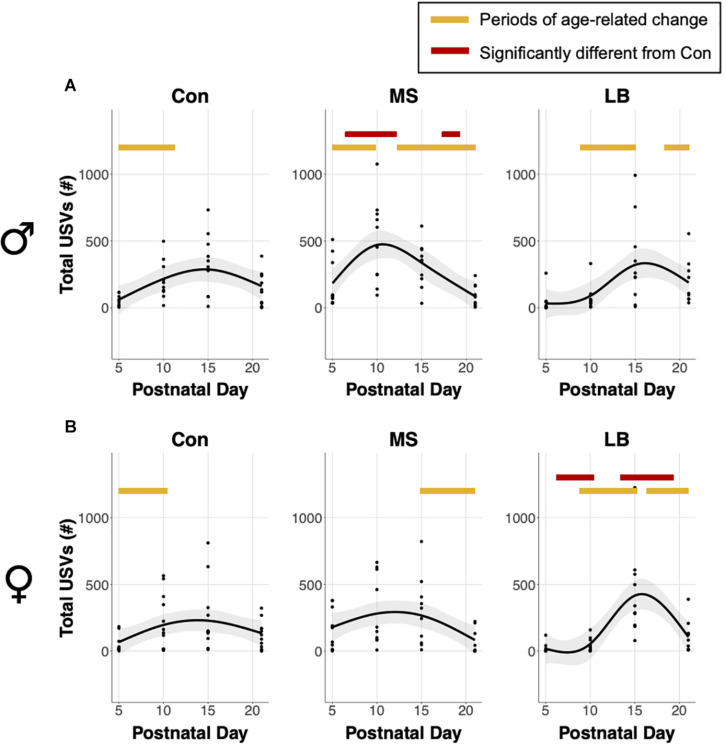
Effects of age and maternal separation (MS) or limited bedding (LB) on total ultrasonic vocalizations (USVs) emitted in (A) males and (B) females. Shaded areas represent 95% confidence intervals. Orange bars indicate periods of significant age-related change based on the derivative of the GAM model fit. Red bars indicate periods significantly different from control (Con) based on differences between GAM models and confidence intervals. n = 9–10.